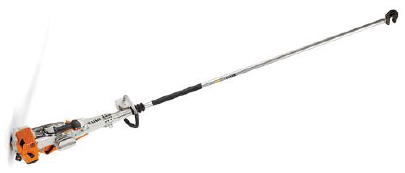
Figure 5. Hook type olive harvesters.